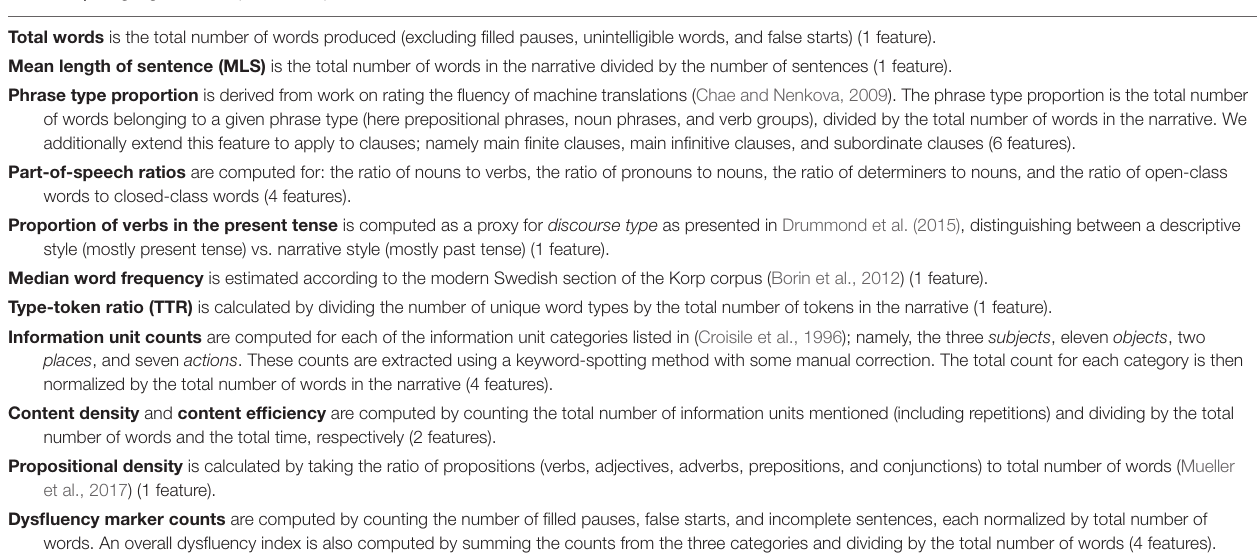
TABLE 2 | Language features (26